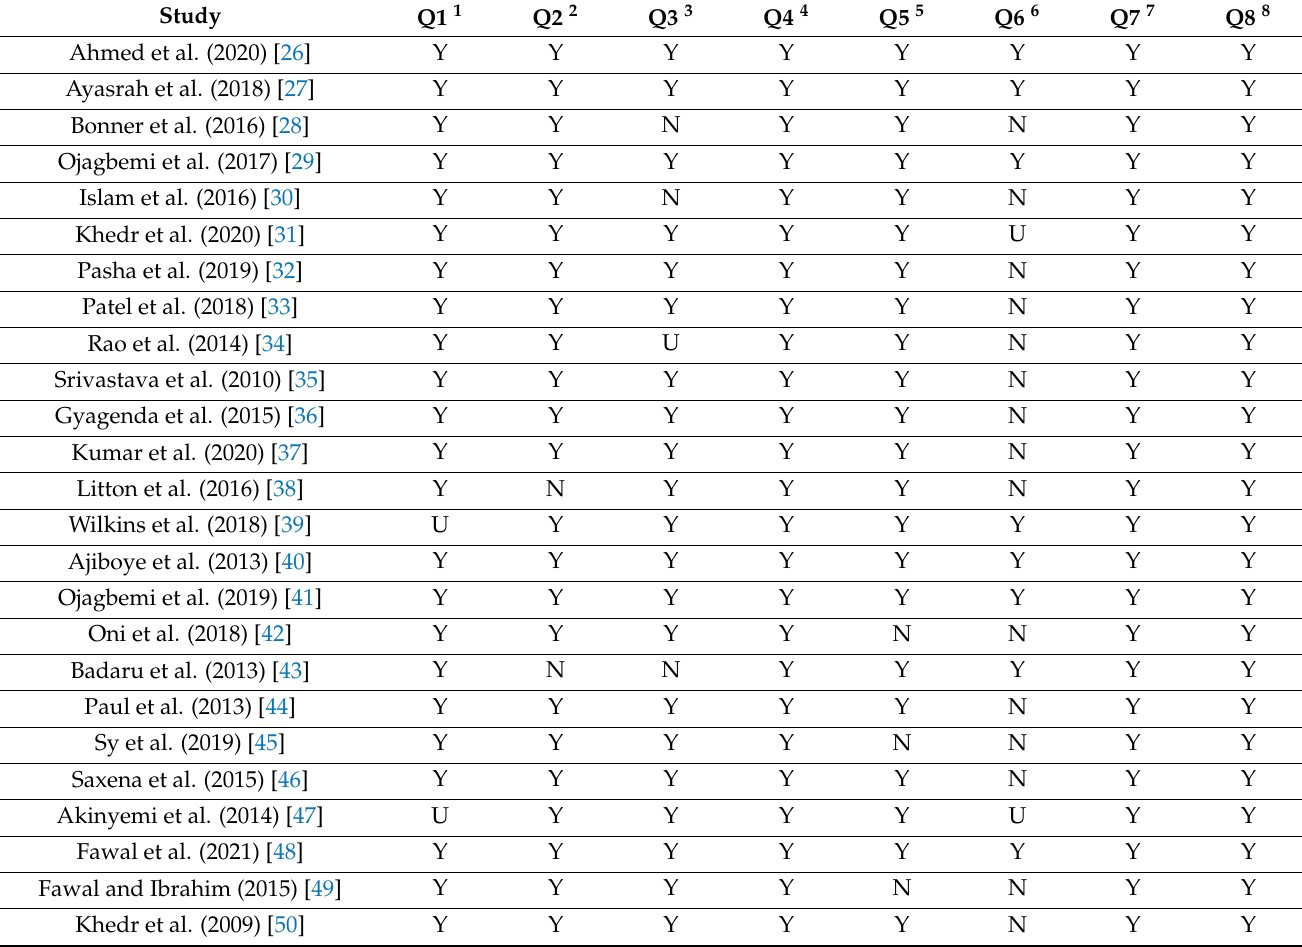
Table 1. Evaluation of the Qualifying Papers using the JBI